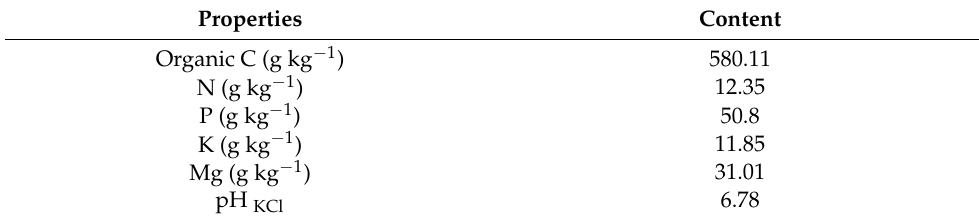
Table 2. Biochar fertiliser properties at the experimental